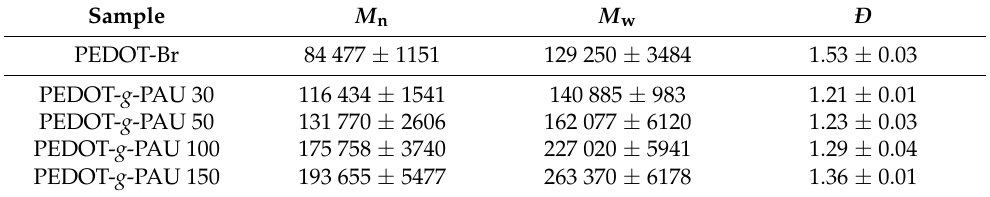
Table 2. Values of numerical ( M n ), mass ( M w ) average molecular weights and dispersity ( Ð